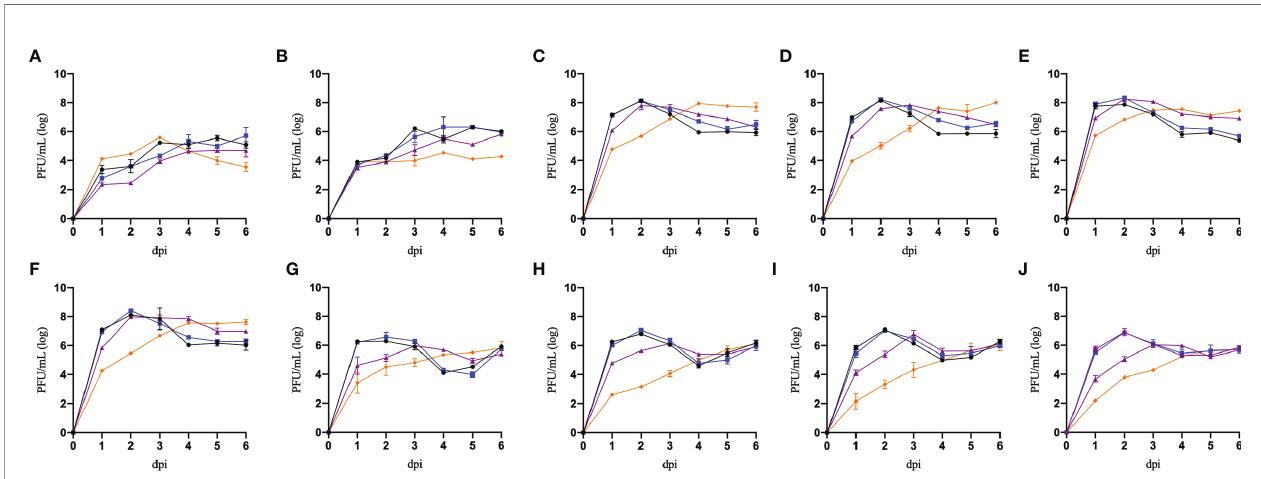
FIGURE 3 | Replication curves of Flavivirus isolates in Vero cells preincubated with recombinant type I interferon. Vero cells were preincubated without recombinant IFN a (black lines), 1 IU/mL of recombinant universal type I interferon IFN (blue lines), 10 IU/mL of recombinant universal type I interferon IFN (purple lines), and 100 IU/mL of universal type I interferon IFN (orange lines) and infected with ten Flavivirus isolates: ZIKV-Oax-2016-1 (A) , DENV2-Oax-2016-2 (B) , DENV2-Oax-2016-3 (C) , DENV2-Oax-2016-4 (D) , DENV2-Oax-2016-5 (E) , DENV2-Oax-2016-6 (F) , ZIKV-Oax-2019-1 (G) , DENV2-Oax-2019-2 (H) , ZIKV-Oax-2019-3 (I) , and ZIKV- Oax-2019-4 (J) at 0.1 MOI. Supernatants of each day were collected and tittered in Vero cells; plaque-forming units (PFUs) are presented on a logarithmic scale. Data are presented as the mean ± SD; n =